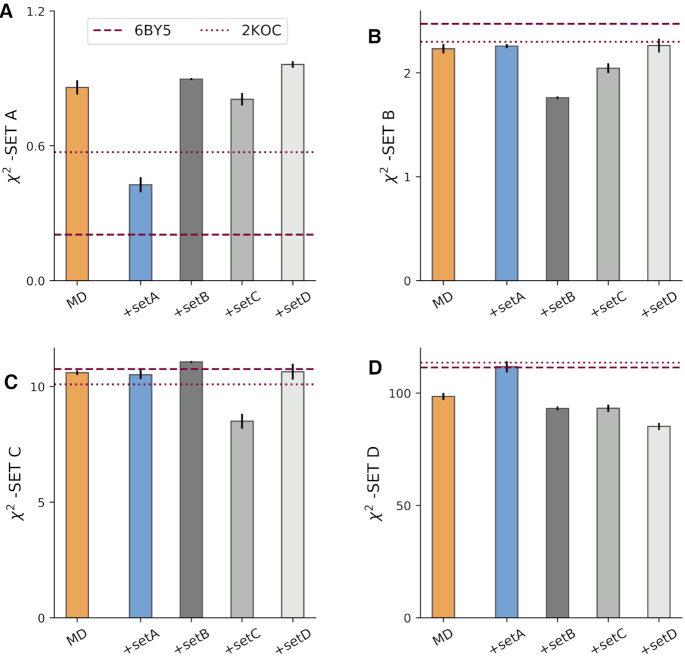
Comparison between experiment and simulations. (A) χ2 between experimental dataset A against the MD ensemble (MD) and against the refined ensembles (MD+set A, MD+set B, MD+set C, MD+set D). As a reference, values calculated from all NMR models from PDB structures 2KOC and 6BY5 are shown as dashed lines. The agreement between the same ensembles and datasets B, C, D, are shown in panels (B), (C) and (D), respectively. Error bars show the standard error estimated using four blocks.